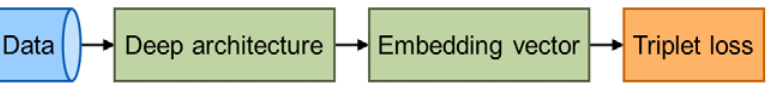
Figure 5. Stage 2 L2-normalization (L2-norm) removal and triplet loss learning model.